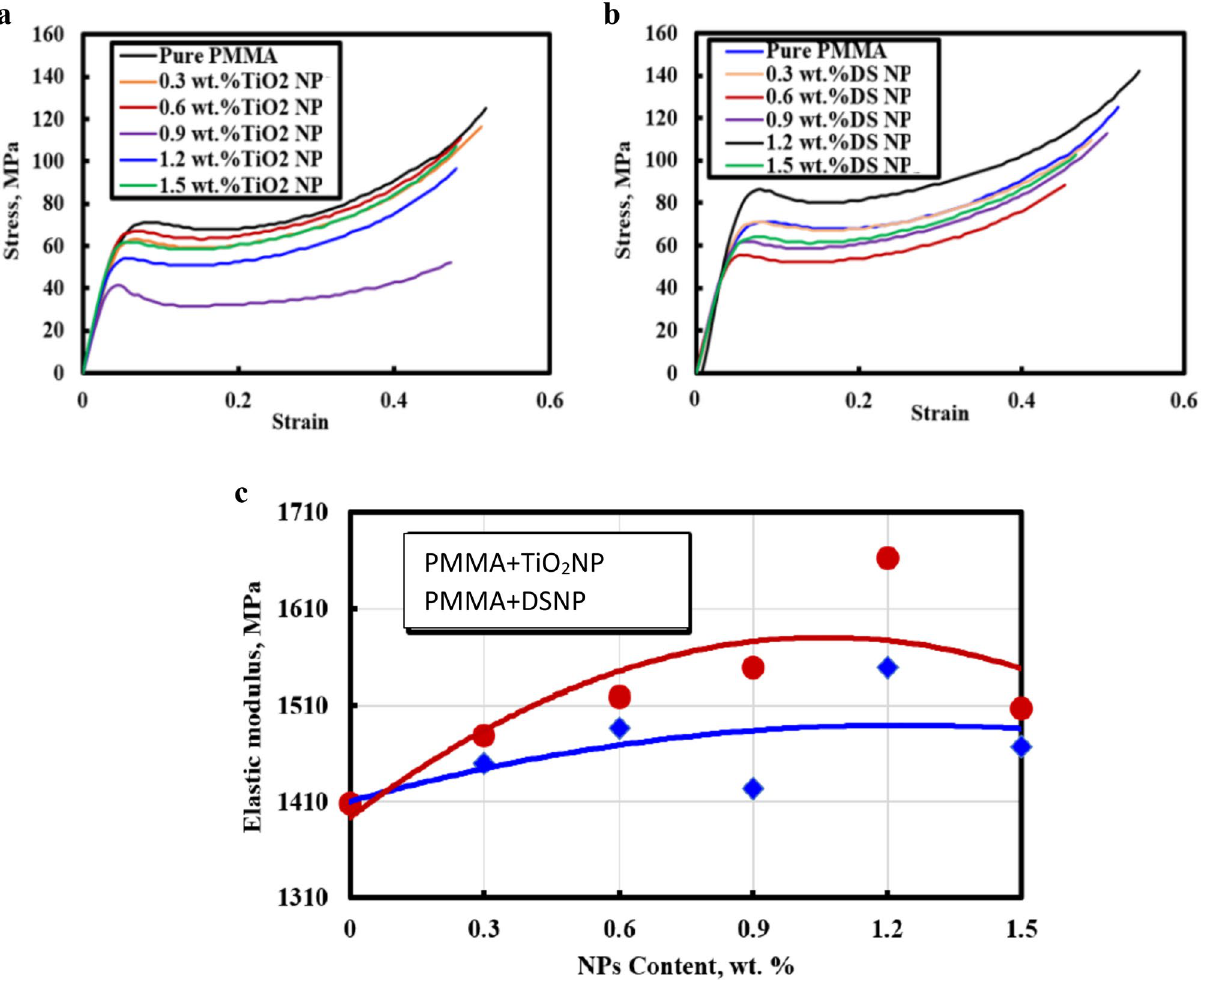
Figure 8. Stress–strain curves for the examined nanocomposites. ( a ) PMMA-TiO 2 NP, ( b ) PMMA-DSNP, ( c ) Modulus of elasticity for the examined nanocomposites.